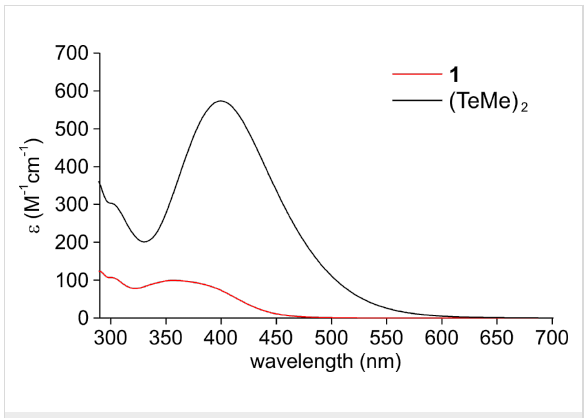
Figure 1: UV–vis absorption spectra of organotellurium chain transfer agent 1 and dimethyl ditelluride in toluene.